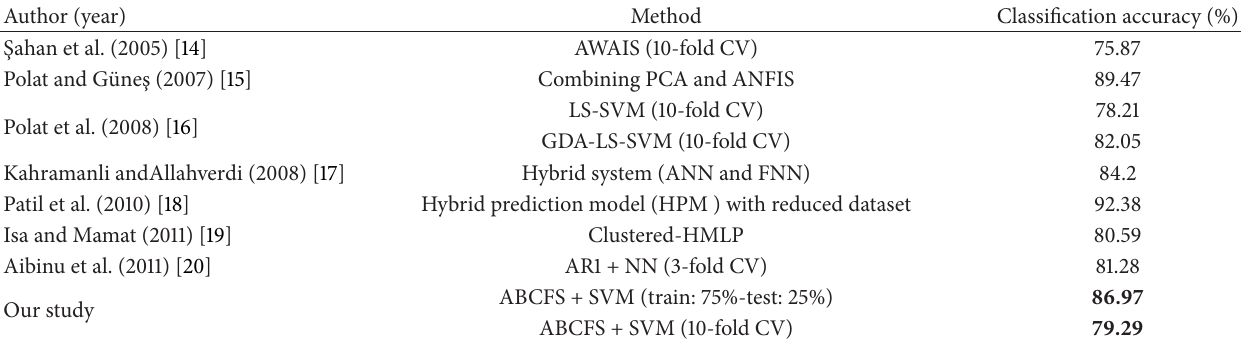
Table 10: Classification accuracies obtained by our method and other classifiers for diabetes